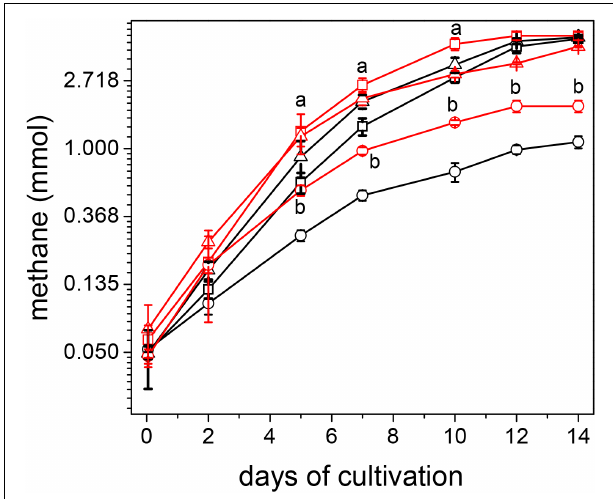
FIGURE 5 | Growth of Methanosarcina acetivorans cultured with Cu 2 + or Zn 2 + . Methane production was determined in control cell cultures in absence ( (cid:3) ) or in presence of Cu 2 + ( ◦ ) or Zn 2 + ( (cid:77) ) as well as in CdPA cells in absence ( (cid:4) ) or in presence of Cu 2 + ( • ) or Zn 2 + ( (cid:78) ). Concentration was 100 µ M for Cu 2 + and Zn 2 + . It is noted that when CdPA cells were cultured in presence of Cu 2 + or Zn 2 + , the 50 µ M Cd 2 + was not added for first time. Values shown are the mean ± SD of 3 independent experiments. a P < 0.01 CdPA vs. control; b P < 0.01 CdPA vs . control (in presence of Cu 2 +